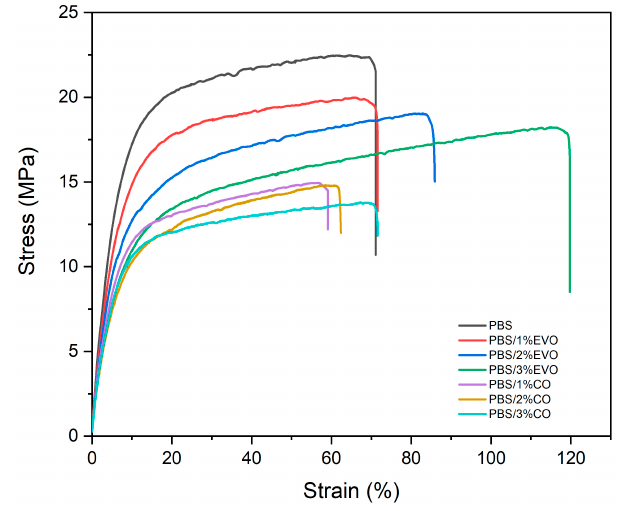
Figure 6. Stress–strain curve of PBS and PBS/formulations. Table 4. Tensile strength, tensile modulus, and elongation at break of PBS and PBS/formulations.